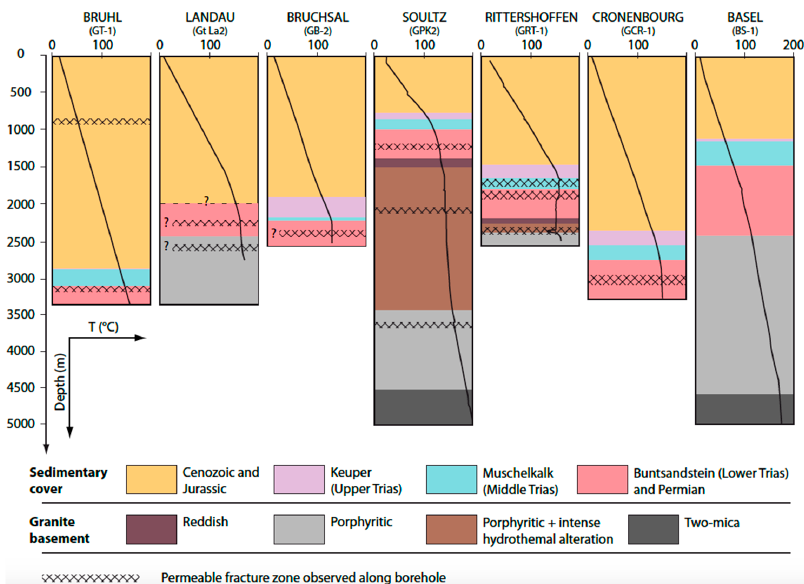
Figure 7. Synthesis of thermal profiles from north (Brühl, Germany) to south (Basel, Switzerland) in the URG, including the Soultz and Rittersho ff en sites in France. The gradient generally shows a slope variation within the sedimentary cover. Modified after [17].